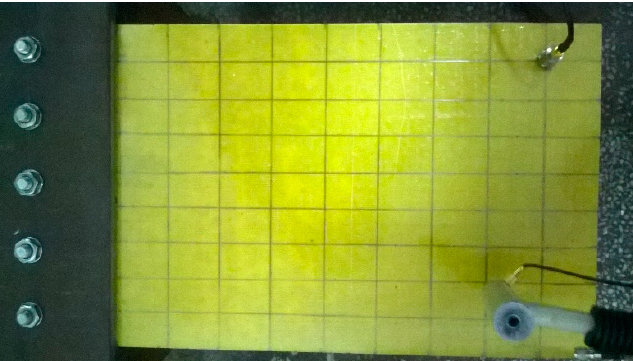
Figure 18. The test model of the laminated plate.